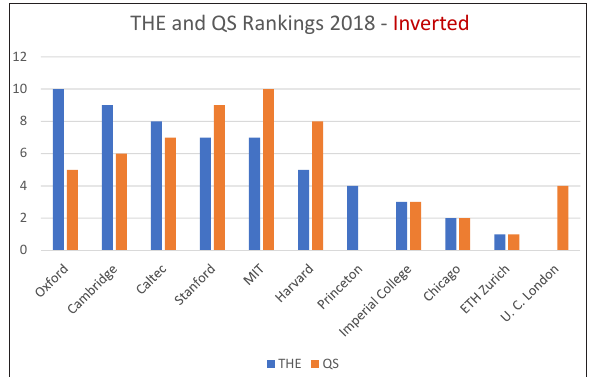
Figure 1: 2018 Rankings for the top 10 institutions as determined by Quacquarelli Symonds (QS) and Times Higher Education (THE) ranking systems. Princeton University does not appear in the QS list and University College London does not appear on the THE